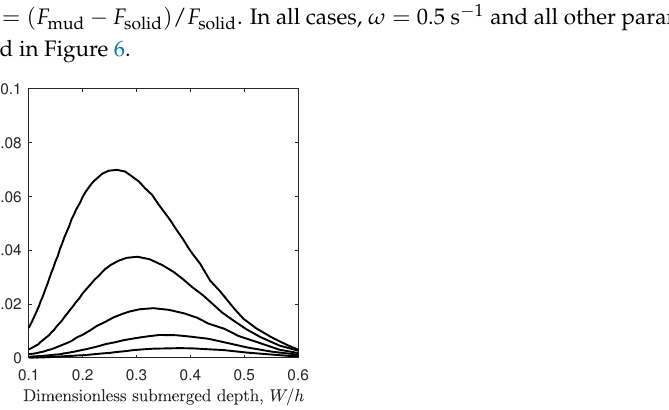
Figure 8. Amplitudes of interfacial waves as functions of dimensionless obstacle submerged depth. Each curve represents a different value of wave frequency with ω = 0.5,0.6,0.7,0.8,0.9 s − 1 (top to bottom). In all cases, ρ w / ρ m = 0.9, ν m = 0.001 m 2 /s, d = δ m , B = 30 m, W = 30